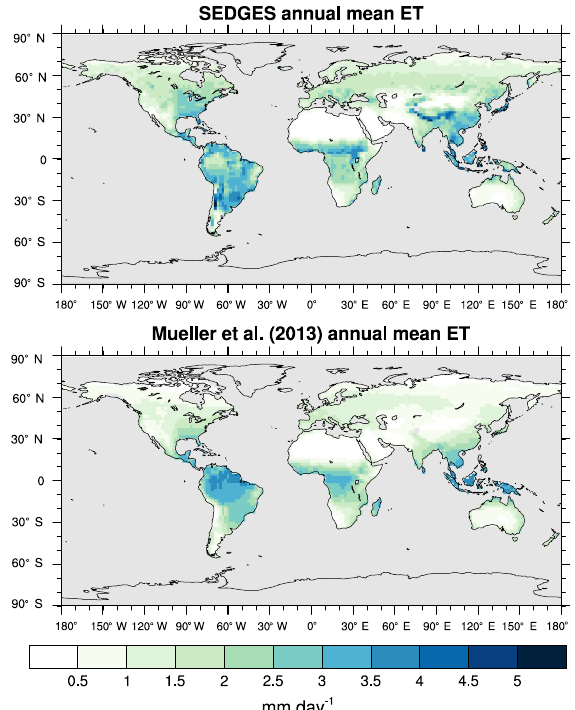
Figure 15. Multiyear annual means of ET for SEDGES and the Mueller et al. (2013) reference dataset for the 1989–2005 period over non-glaciated